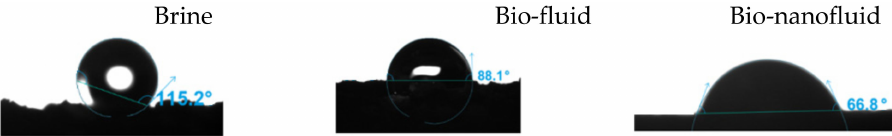
Figure 13. Contact angles measurements of the water phase. Brine, bio-fluid, and bio-nanofluid were used to treat previously aged cores. The experiments were performed at reservoir temperature (47 ◦ C). The treatment was carried out for 48 h at reservoir